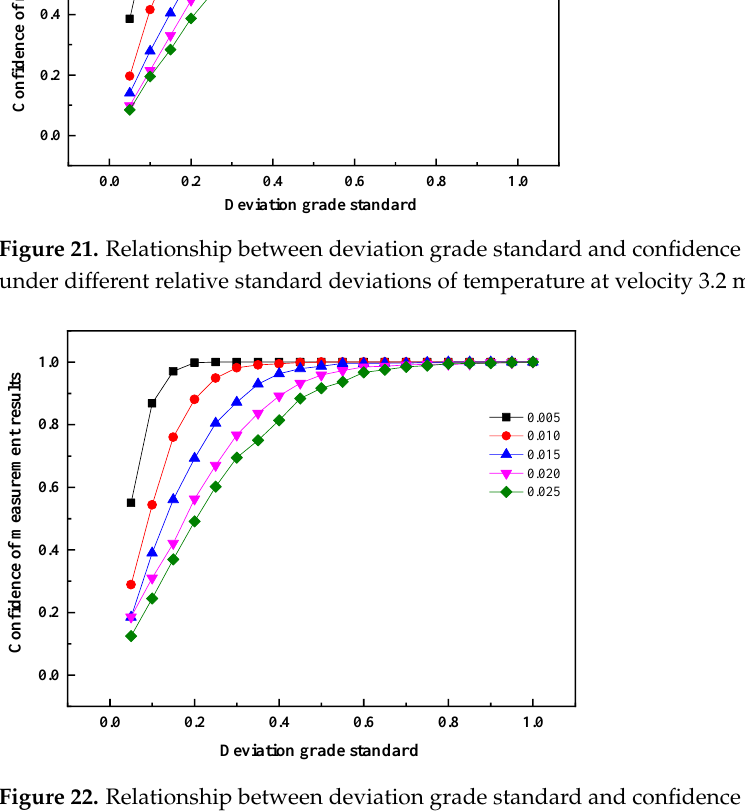
Figure 23. Relationship between deviation grade standard and confidence of measurement results under different relative standard deviations of temperature at velocity 5.05 m/s. Figure 24. Relationship between mean velocity and the confidence of the measurement results under different relative standard deviations of temperature at deviation grade standard 0.25. It can be seen from Figures 19 – 23 that the velocity at the catalyst inlet has a great impact on the confidence of the measurement results under the relative standard devia- tion of temperature. It can be seen from Figure 24 that under the same relative standard deviation of temperature, the confidence of measurement results decreases first and then increases with the rise of velocity. When the inlet velocity is 2.1 m/s, the confidence of measurement results reaches the minimum. Figure 18 shows the opposite trend with Figure 24; the smaller the center concentration deviation, the higher the confidence of